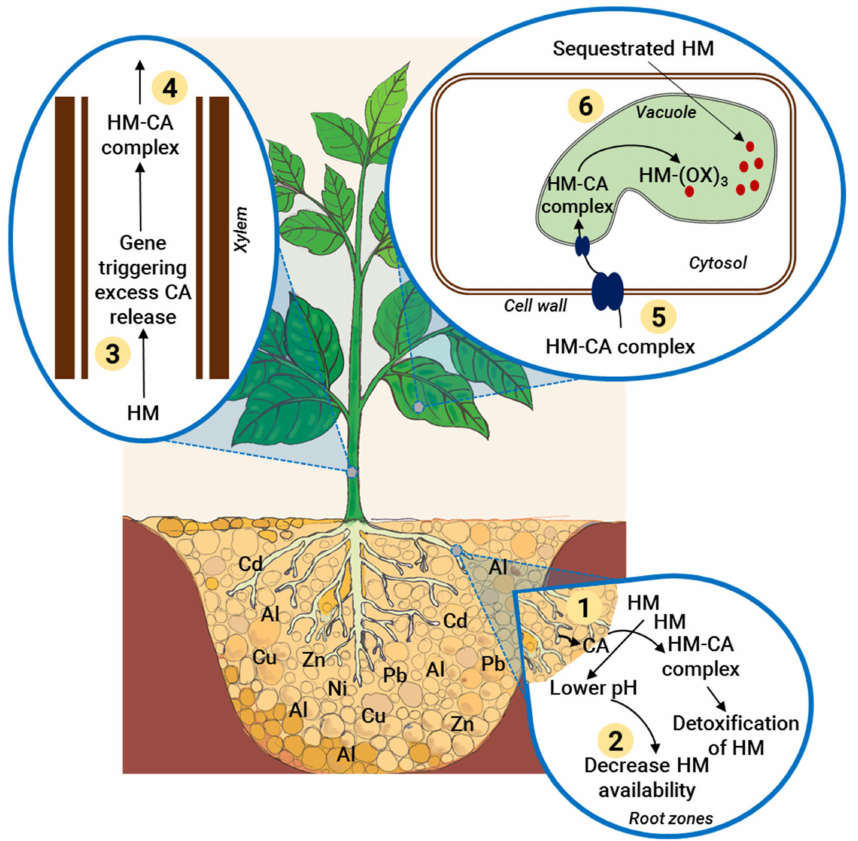
Figure 2. Mechanisms of HM stress tolerance mediated by citric acid (CA). In response to HM- containing soil, ( 1 ) plant roots release exudate containing CA whereupon CA can detoxify HMs by forming HM-CA complexes. ( 2 ) Moreover, organic acids like CA decrease the rhizosphere pH and cause precipitation of HMs. ( 3 ) Sensing of HMs activates genes involved in CA release in the shoot xylem. ( 4 ) HMs form HM-CA complexes through ligand exchange reactions with citrate. ( 5 ) Com- plexes of HM-CA, once transferred from xylem to leaf cells through iron regulated/Ferroportin family transporters or ABC transporters, undergo another ligand exchange reaction to reform HM-oxalate complexes which are deposited in the vacuole. ( 6 ) HMs are sequestered in the cytosol through phyotochelation and transplanted into tonoplast via